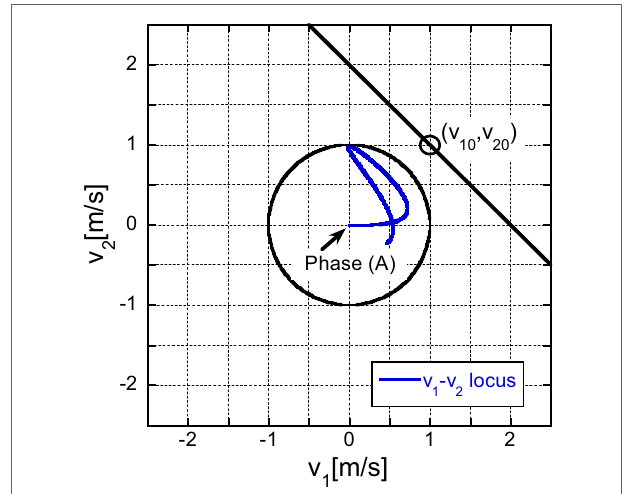
FigUre 21 | Velocity (first-story mass)–Velocity (second-story mass) plane for variable motion of masses bounded by shrinked circle and the actual motion of masses starting from the phase (a) (only the first impulse is given).